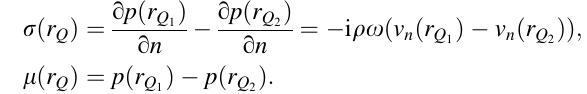
Fig. 9 Comparison of vibration acceleration PSD curves at measur- ing